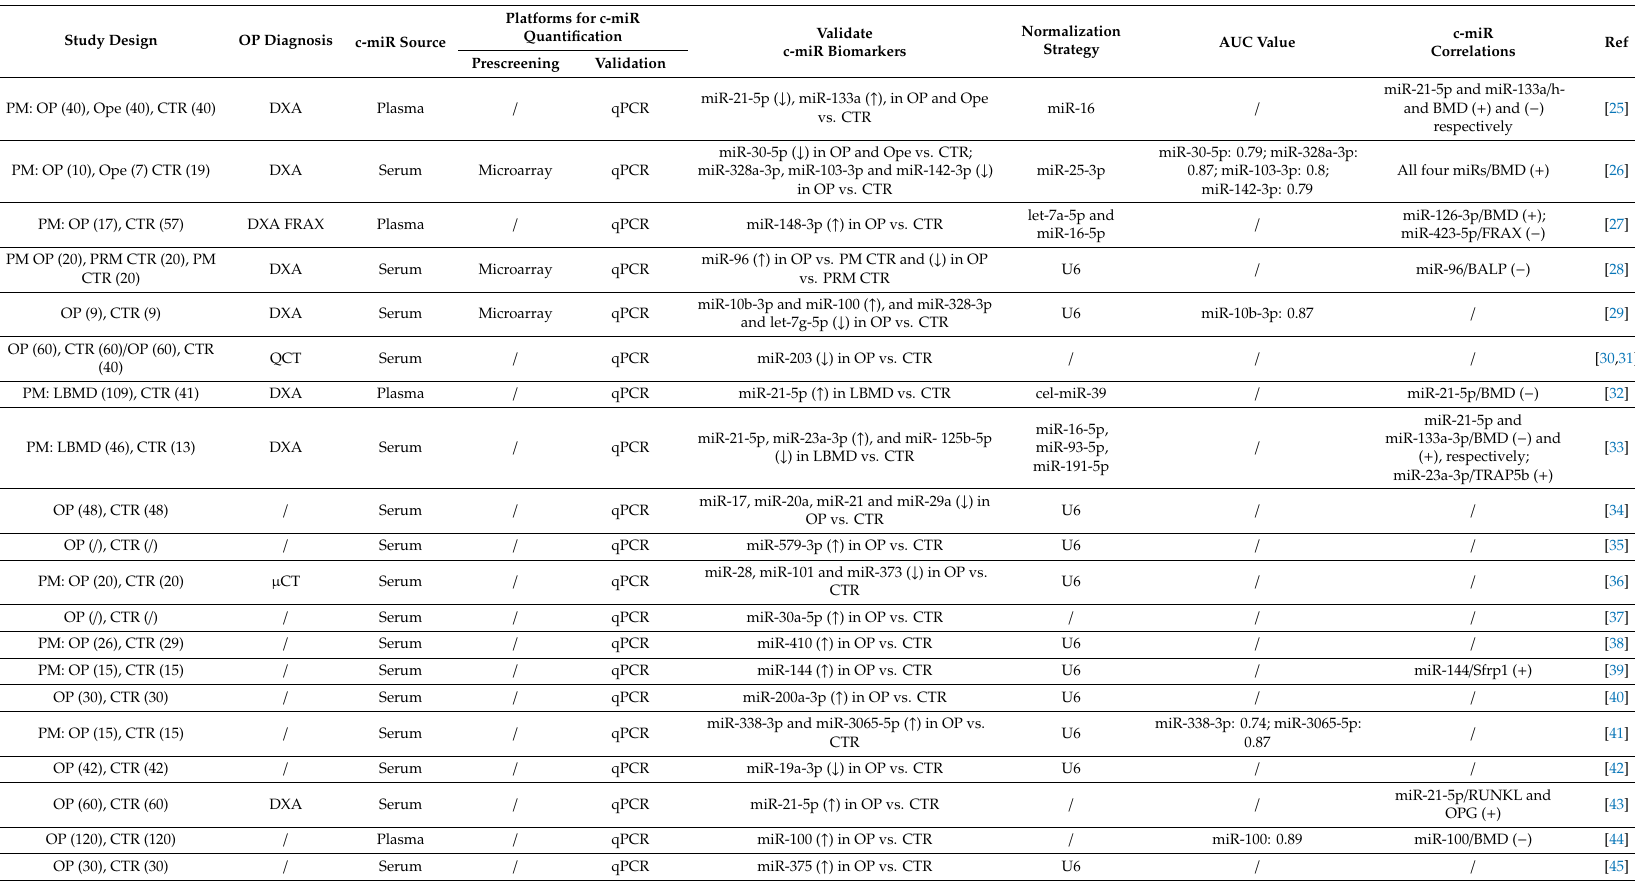
Table 1. Overview of studies that have identified cell-free microRNAs (c-miRs) as biomarkers to distinguish osteoporosis / osteopenia (OP / Ope) patients from normal bone mineral density (BMD) without fragility fracture (woF)